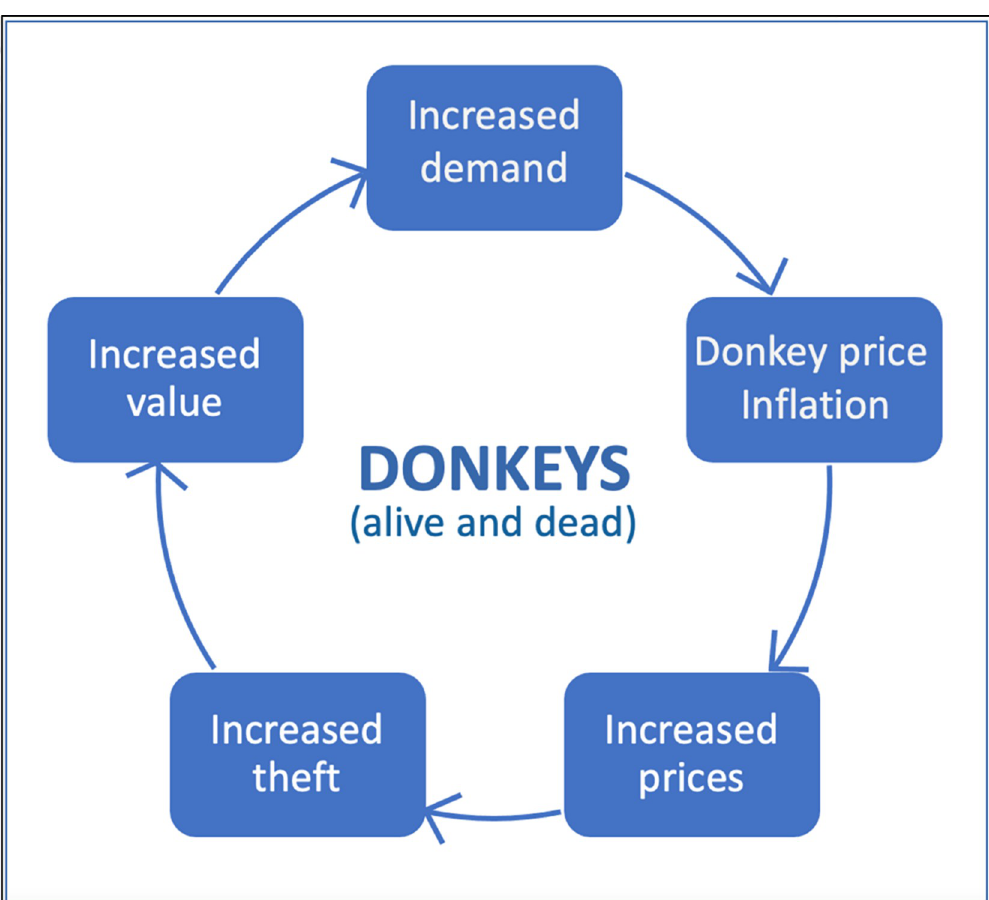
Fig 11. The negative feedback cycle of the market for donkeys in northern Ghana. Source: Maggs, 2022 [1].